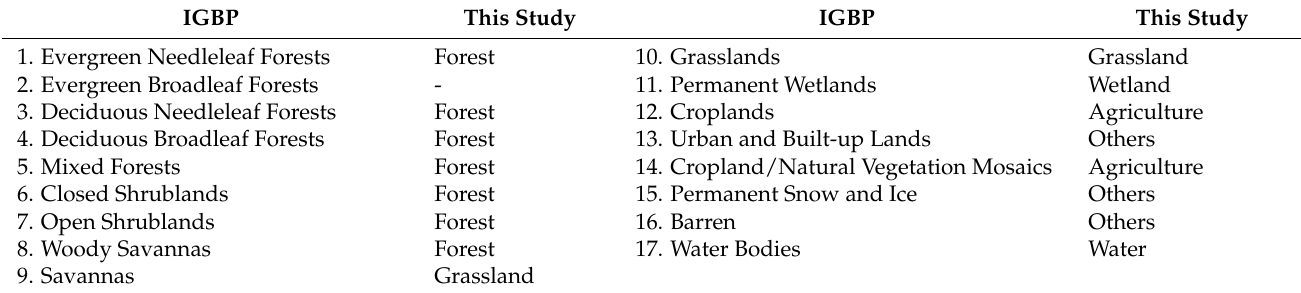
Table 1. Reclassification of Land Cover and Land Use Data in the Amur-Heilong River Basin (ARB). IGBP This Study IGBP This